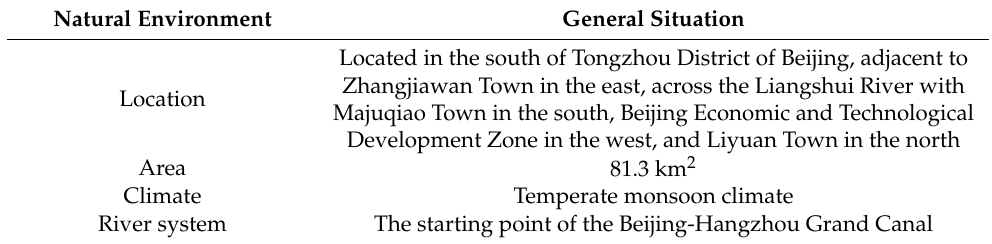
Figure 1. Location of Taihu Town (Beijing, China). Table 1. Overview of Taihu town.